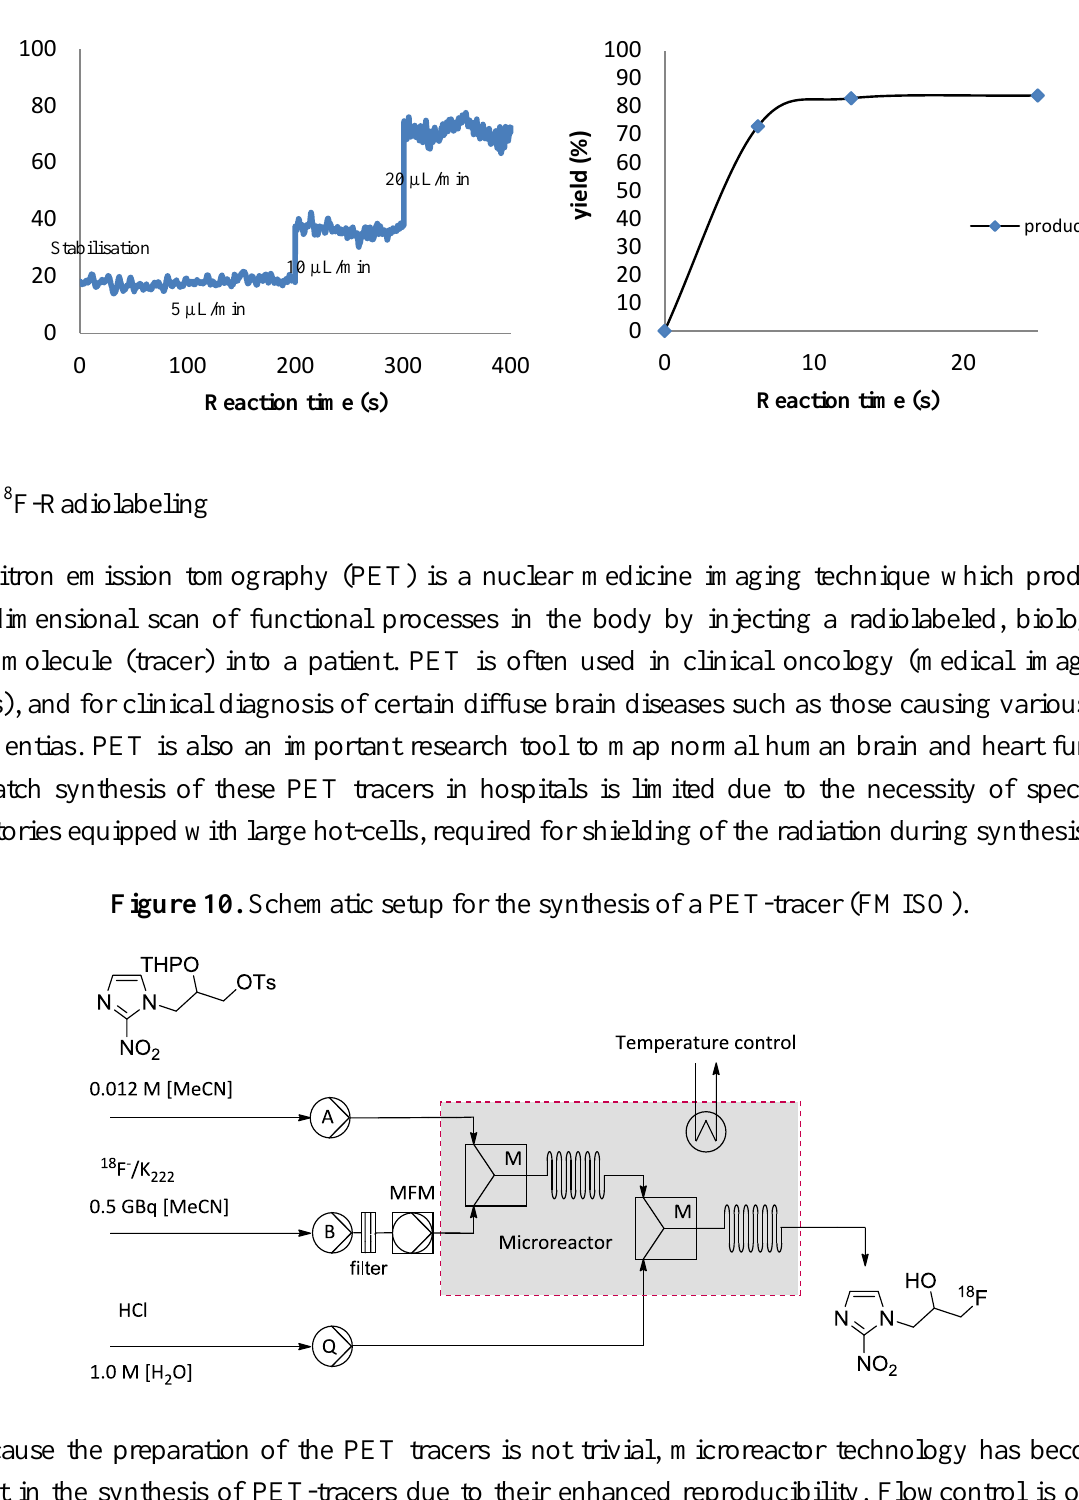
Figure 9. Flow metering of the Grignard reaction.